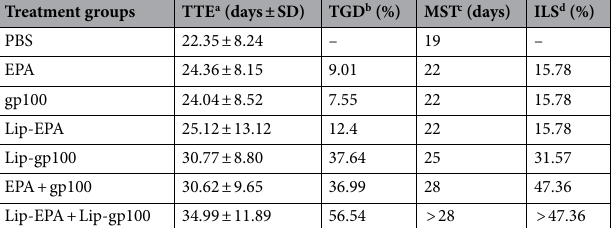
Table 5. Data on the effectiveness of different treatments in B16F10 tumor bearing mice. a Time to reach end point; b Tumor growth delay; c Median survival time; d Increased life span.